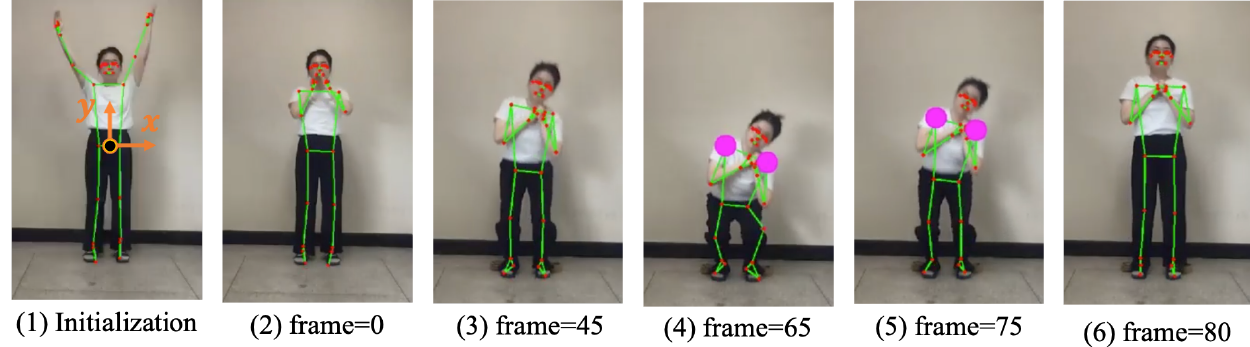
Figure 13. Results of visualized error points in the real-time through dynamic time warping (DTW): ( a ) Errors in the left lower limb; ( b ) errors in both shoulders. This function to visualize errors in real-time helps correct the poor exercise pose of the user by